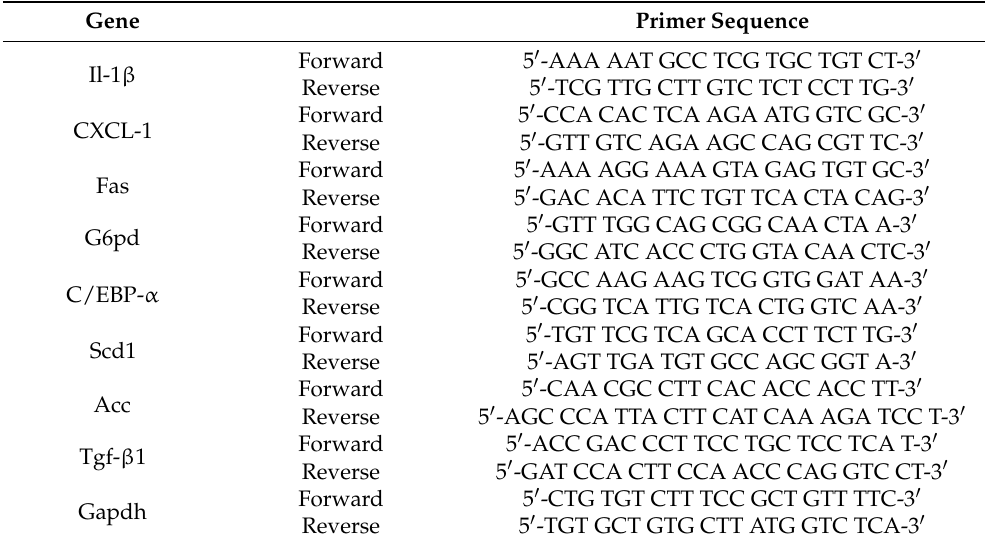
Table 3. Primer sequences for quantitative real-time polymerase chain reaction (qRT-PCR). Gene